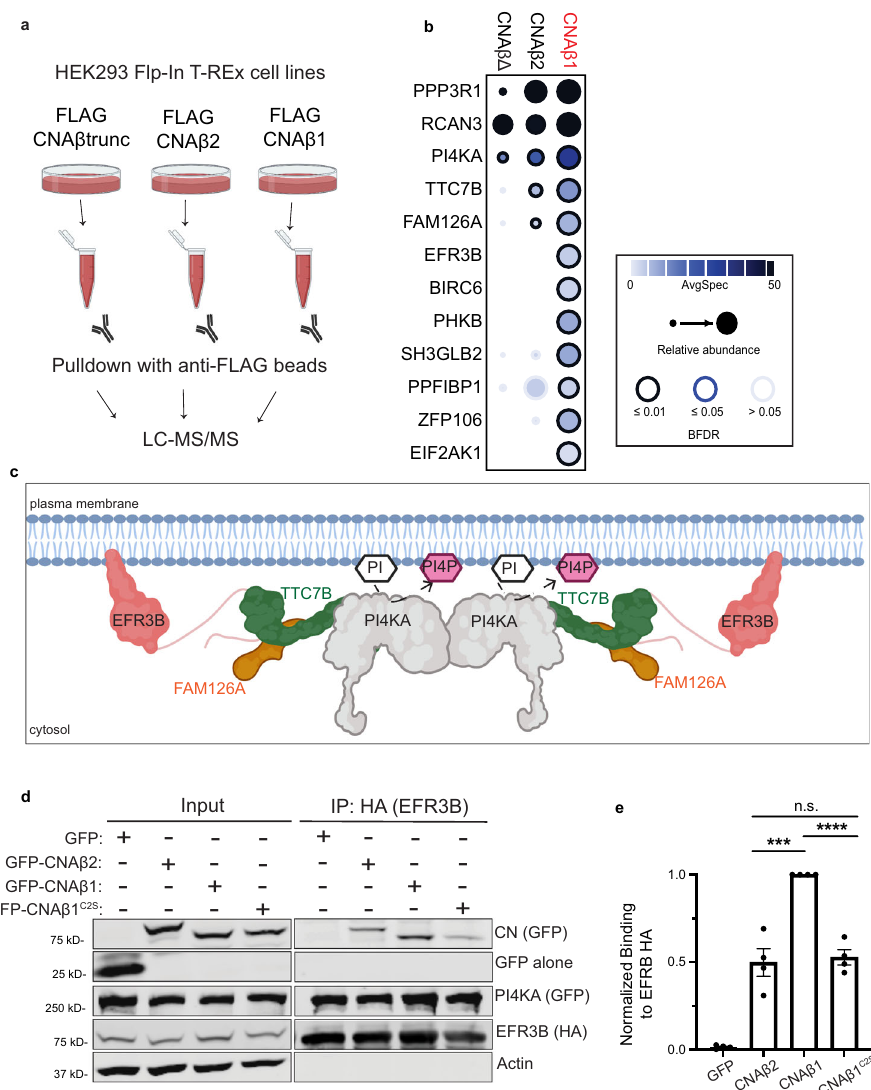
Fig. 3 CNA β 1-enriched interactors are membrane-associated and include all PI4KA complex members. a Schematic of experimental plan for AP-MS analyses (created using BioRender.com). b Dotplot of AP-MS results including CNA β 1-enriched interactors (those with spectral counts (cid:1) 1.5x more for CNA β 1 than other baits). Node edge color corresponds to bayesian false discovery rate (BFDR), node size displays prey abundance and node darkness represents number of spectral counts. Full results reported in Supplementary Fig. 3c and Supplementary Data 1. c Cartoon representation of the structural organization of the phosphatidylinositol 4-kinase complex containing PI4KA (gray), FAM126A (orange), TTC7B (green) and EFR3B (pink). PI Phosphatidylinositol (white), PI4P phosphatidylinositol 4-phosphate (purple). d Immunoblot analysis of anti-GFP immunoprecipitates from inducible Flp- In-T-REx cells expressing GFP-CNA β 2, CNA β 1, or CNA β 1 C2S , transfected with EFR3B-HA, TTC7B-MYC, FLAG-FAM126A, and GFP-PI4KA. ( n = 4 independent experiments) e Amount of GFP-CNA β 2 and GFP-CNA β 1 C2S co-puri fi ed with EFR3B-HA, quanti fi ed as bound GFP signal/bound HA signal normalized to input. Data are mean ± SEM ( n = 4 independent experiments). n.s. not signi fi cant ( p = 0.7 ) , *** p = 0.0007, **** p < 0.0001 using unpaired, two-tailed t